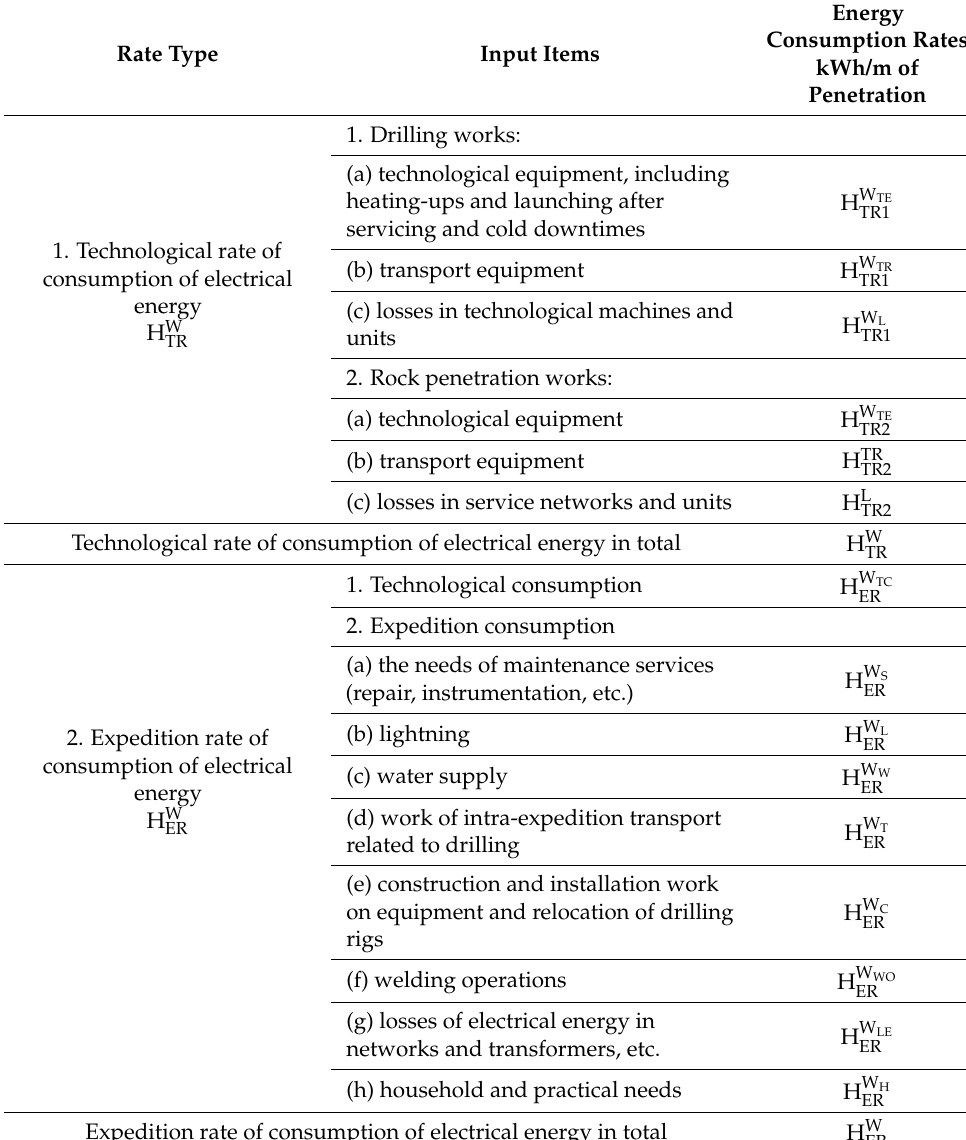
Table 1. Composition of consumption rates of energy resources for fulfillment of survey and techno- logical operations during